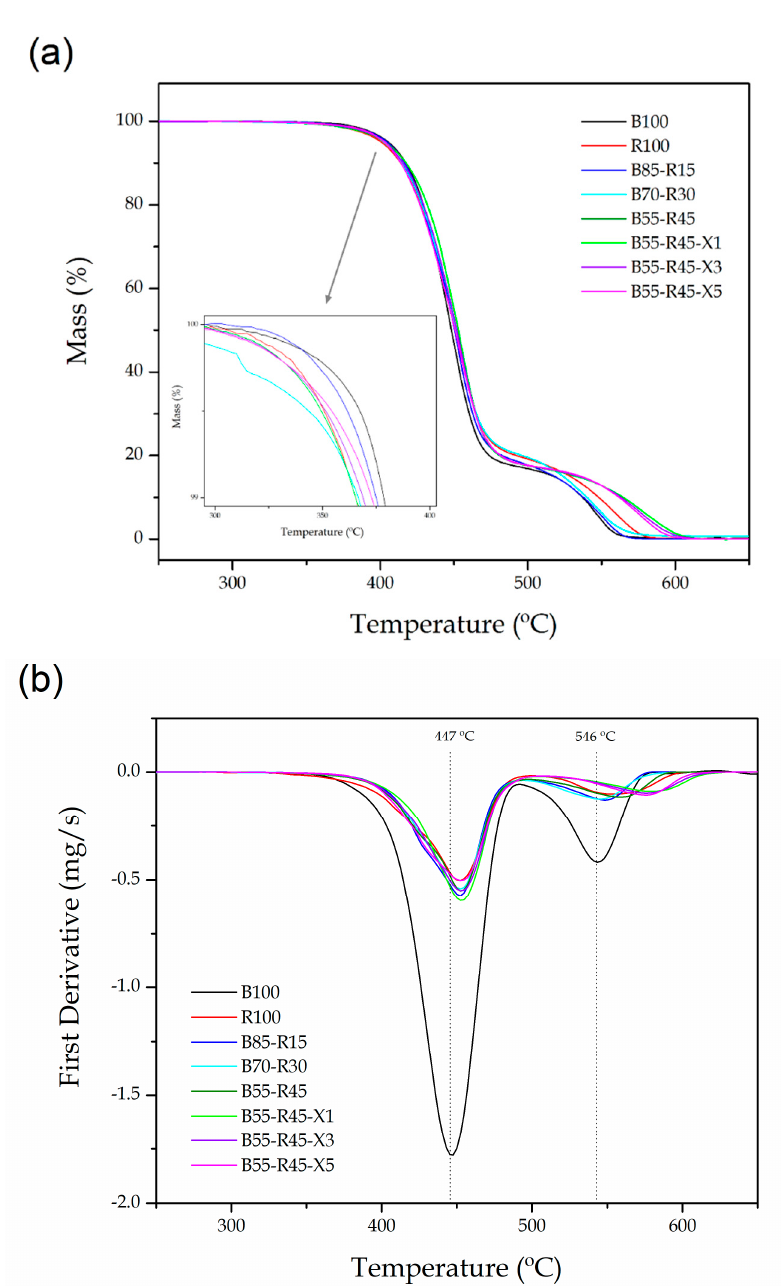
Figure 5. ( a ) Thermogravimetric analysis (TGA) and ( b ) first derivative thermogravimetric (DTG) curves of the injection-molded pieces of the partially bio-based and recycled polyethylene terephthalate (bio-PET/r-PET)